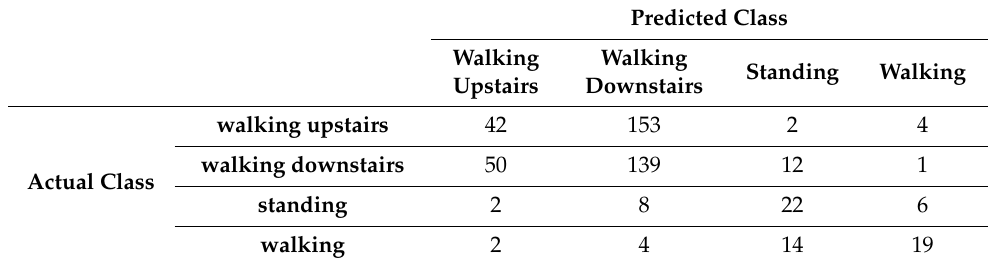
Table 3. Confusion matrix for normalized accelerometer data with MinMaxScaler.